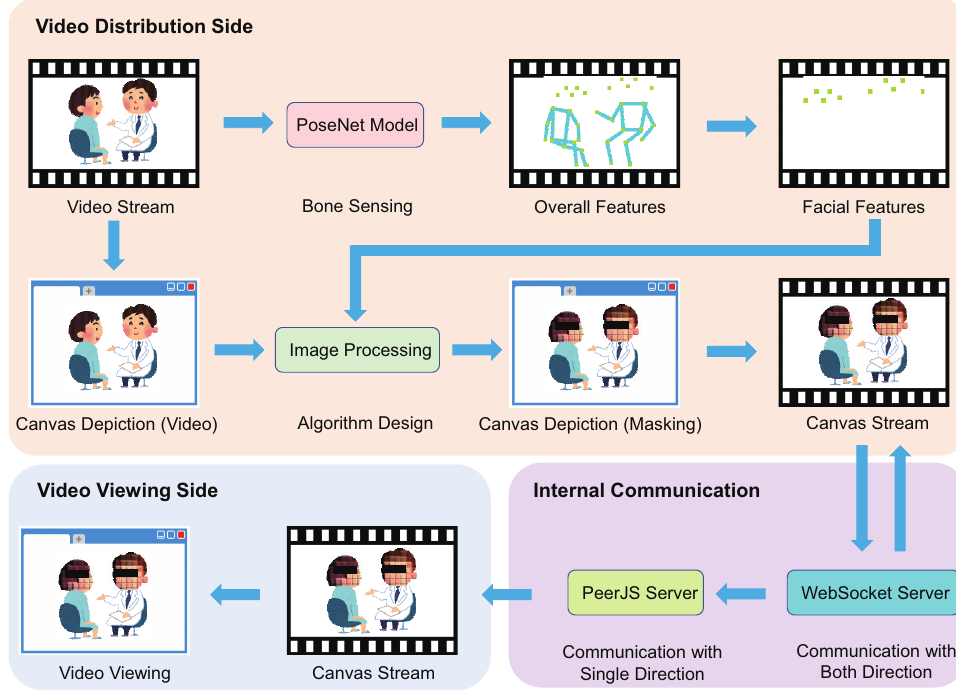
Figure 2. Technical architecture in the proposed method.